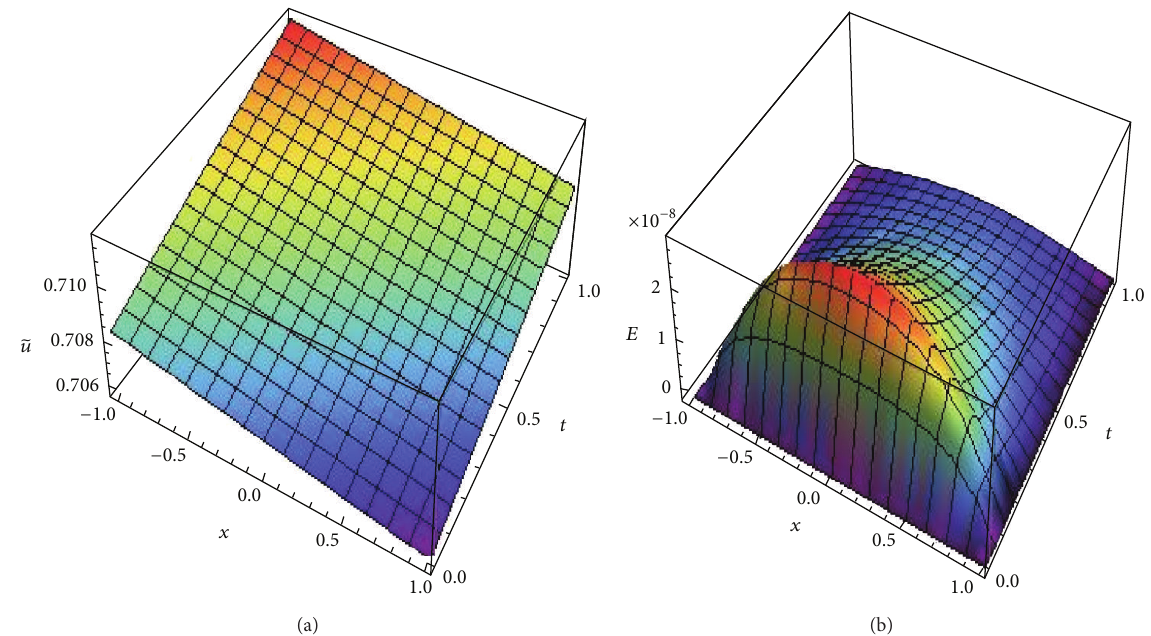
Figure 5: The result of the L-GL-C method at ] = 𝛾 = 10 −2 , 𝛿 = 2 , and 𝑁 = 20 . (a) The approximate solution. (b)The absolute error.